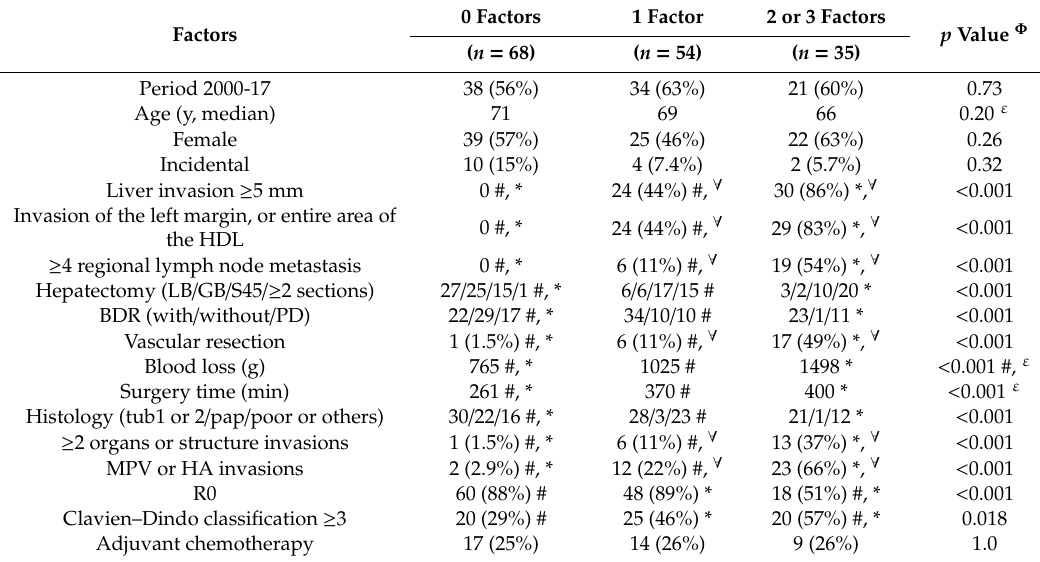
Figure 1. Comparison of overall survival (OS) based on the number of prognostic factors predicted preoperatively in patients with stage 3 / 4 gallbladder cancer without distant metastases. * < 0.05, ** < 0.01. Table 3. Comparison of characteristics among groups according to the number of prognostic factors in patients with stage 3 / 4 gallbladder cancer without distant